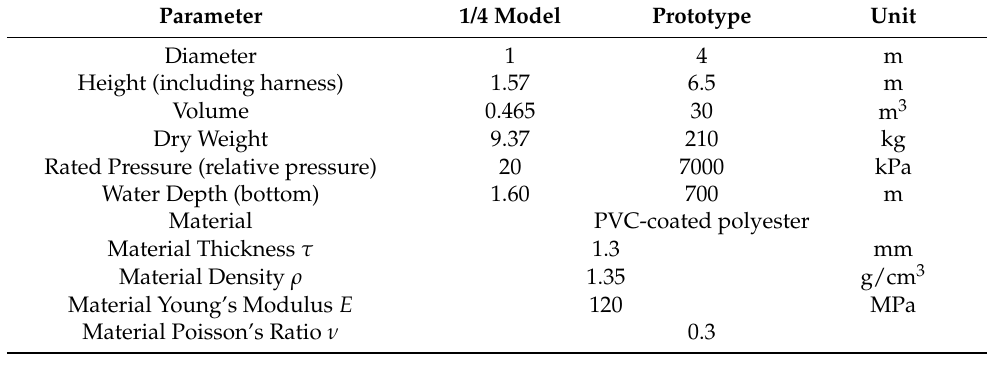
Table 1. Specifications of the testing model and prototype.